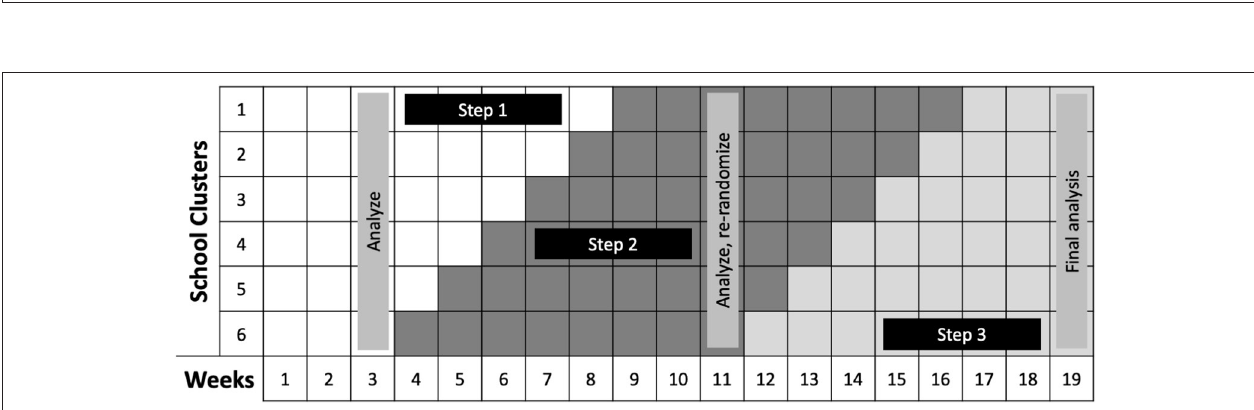
FIGURE 5 | SMART/Stepped Wedge Design for School Re-Opening. Credit: Dr. Naomi Bardach, University of California, San Francisco. In this design, Steps 1–3 each represent an increasing number of in-person students. The team will conduct baseline: (1) PCR COVID-19 testing at all schools, for students and teachers and staff, and (2) student and teacher surveys regarding exposure and symptom history. Then, weekly PCR testing for a random sampling of students and staff within each school cluster will be conducted to determine if changes from Step 1 to Step 2 will be allowable after 3 weeks. If no new outbreaks occur during the move to Step 2, nor during the weeks 9–11 when all schools are in Step 2, all school clusters will be newly randomized and move to Step 3 practices. If no or limited outbreaks occur, we will recommend staying in Step 3 restrictions. Should there be large outbreaks or several small outbreaks in any of the schools in any of the stages, schools can return to the more restrictive Step 2